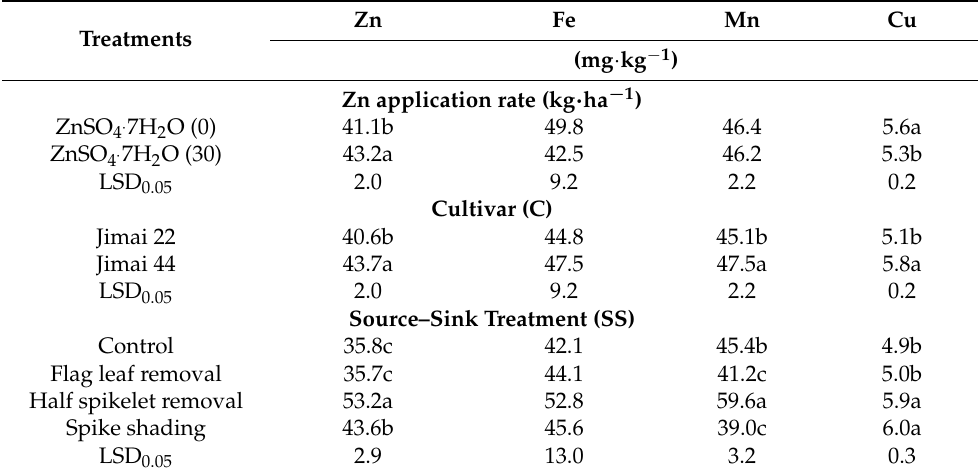
Table 2. Effects of soil Zn application and source–sink manipulations on concentrations of Zn, Fe, Mn and Cu in grains of different wheat